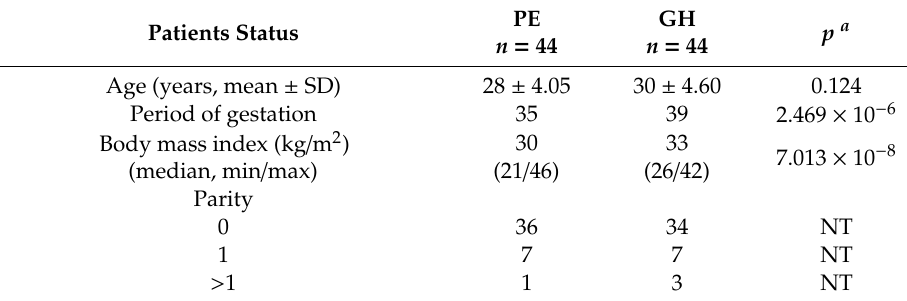
Table 1. Patient